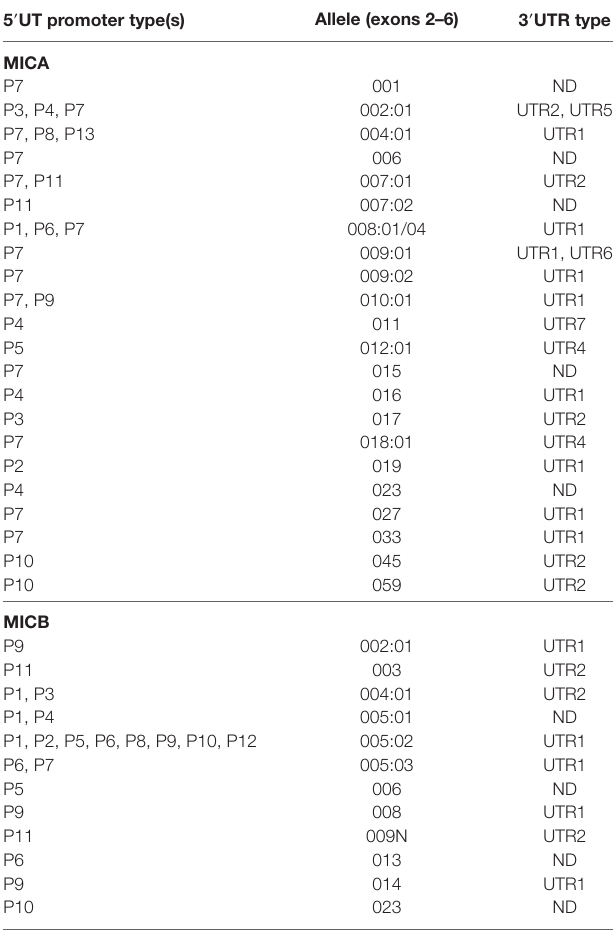
TaBle 1 | MICA and MICB 5 ′ UT promoter, allele and 3 ′ UTR allelic